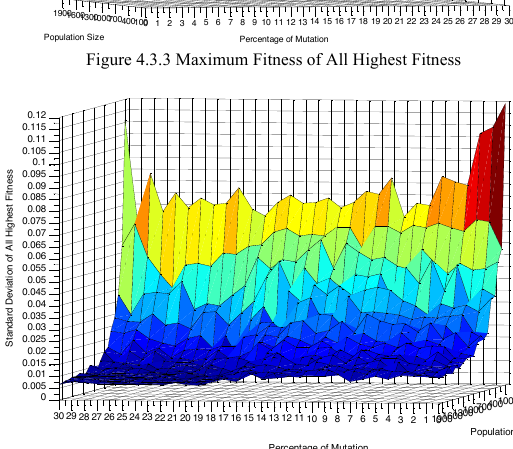
Figure 4.2.3 Maximum Fitness of All Highest Fitness